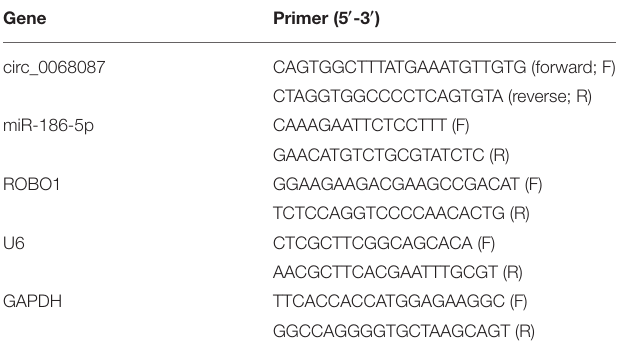
TABLE 1 | Primer sequences in RT-qPCR